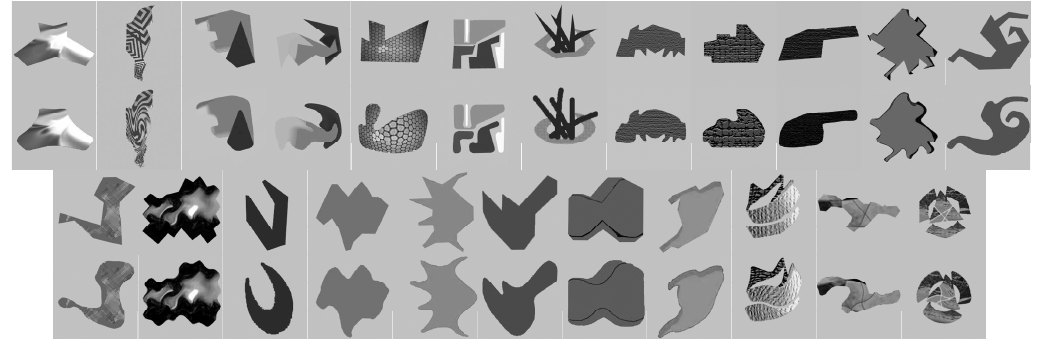
Figure 3. Twenty-three pairs of images from the database, where the images in first and third rows have sharp contours and the images in the second and fourth rows have the curved contours.